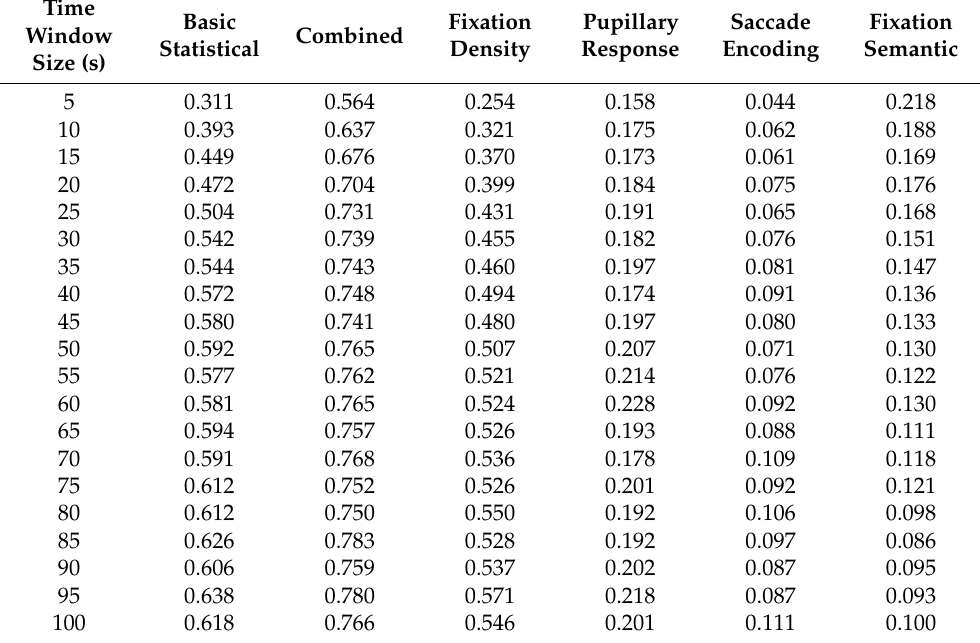
Table A1. Mean accuracy of the 10-fold identification scenario.